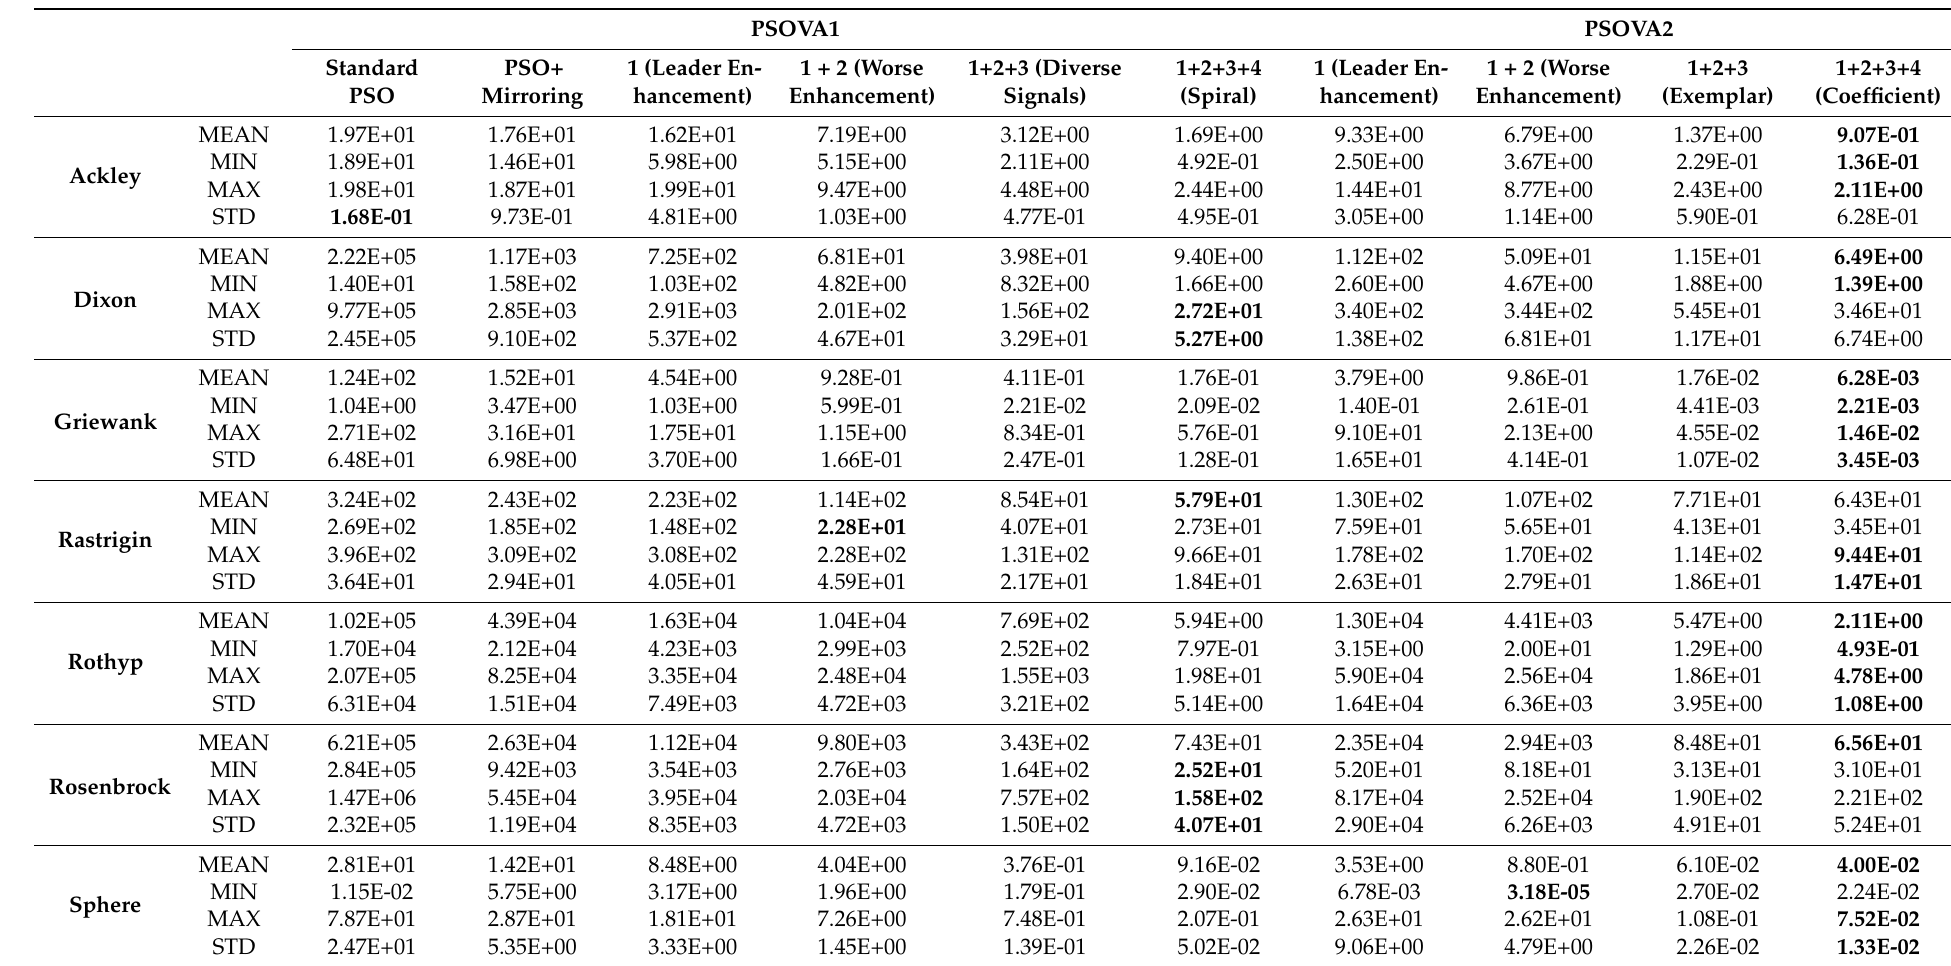
Table 11. Evaluation results for 11 benchmark functions with dimension =